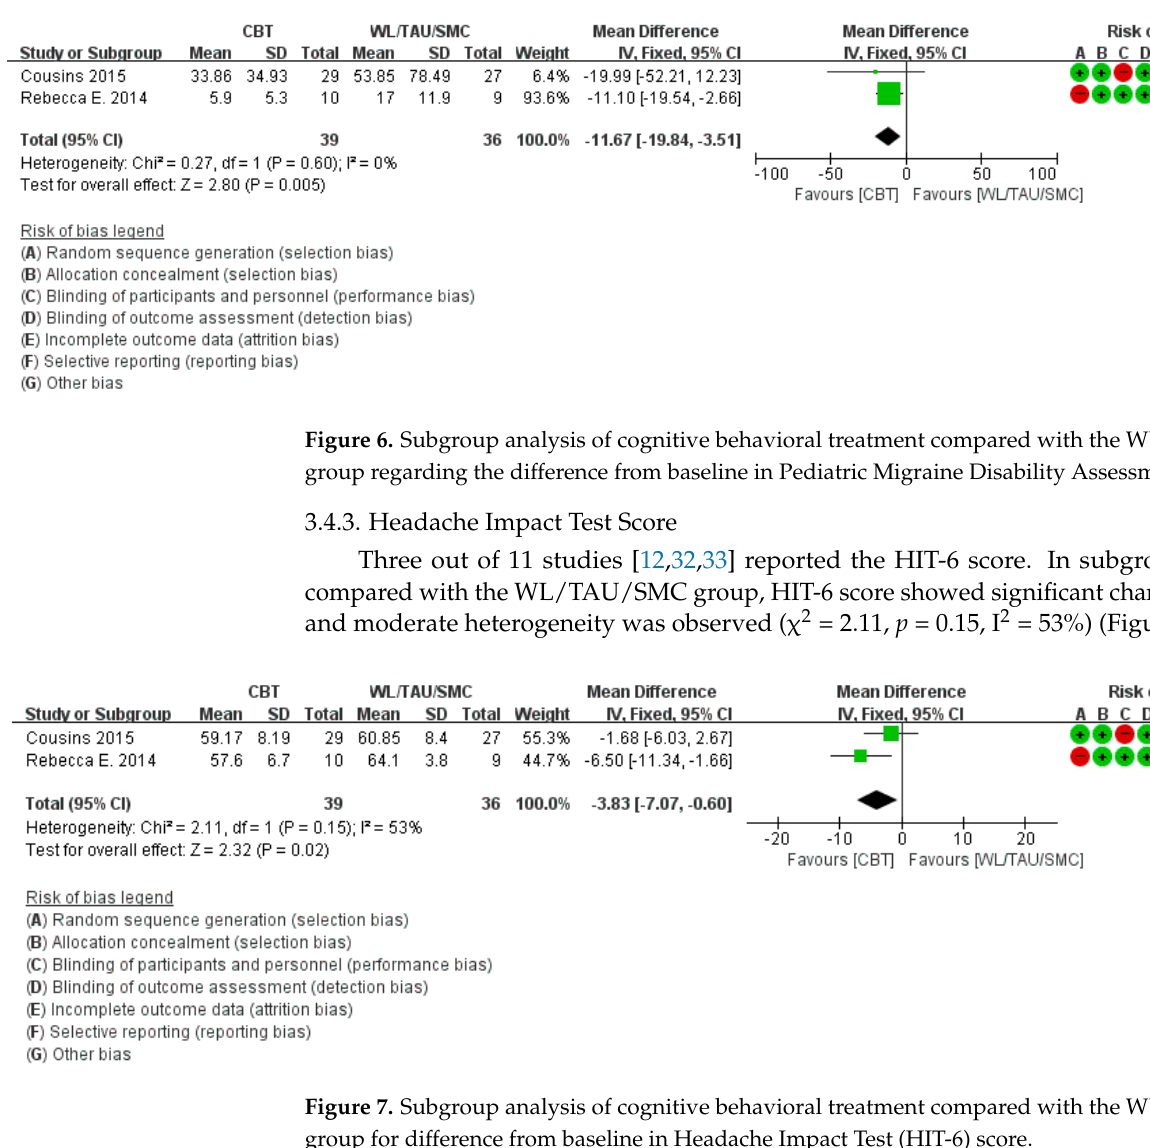
Figure 5. Subgroup analysis of cognitive behavioral treatment compared with the education group regarding the difference from baseline in Pediatric Migraine Disability Assessment score.